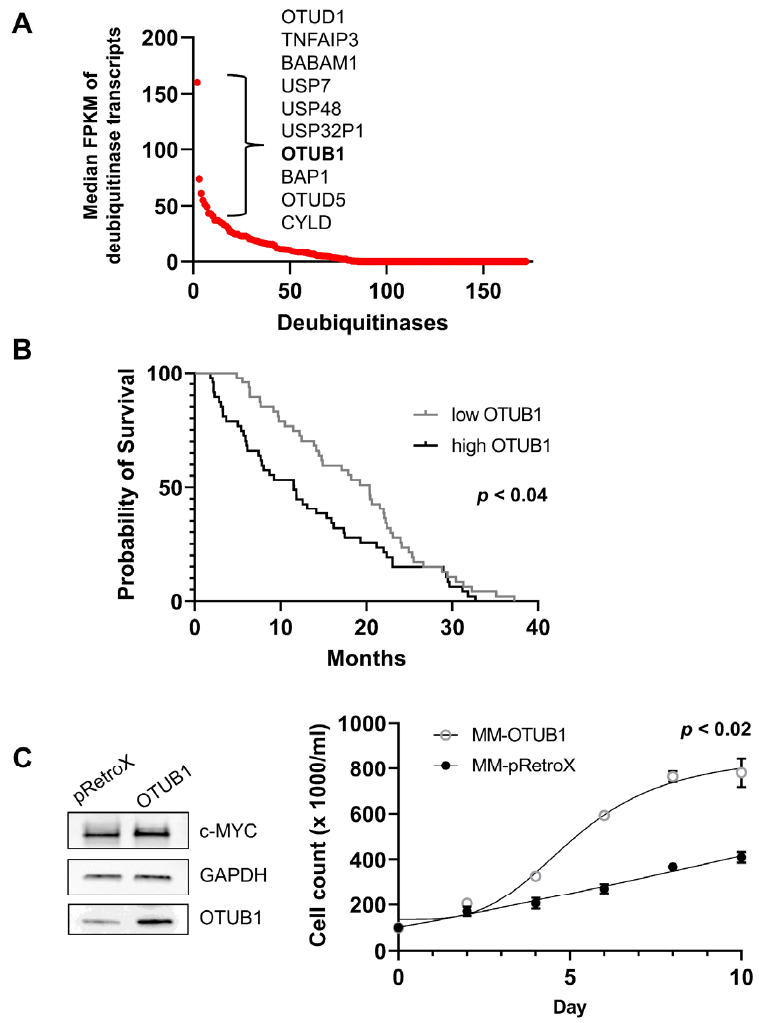
Figure 7. OTUB1 has oncogenic potential in multiple myeloma. ( A ) Analysis of expression levels of deubiquitinases in primary multiple myeloma cells of 811 patients. OTUB1 was among the top 10 enzymes of this class expressed in these cancer cells. ( B ) Multiple myeloma patients with elevated OTUB1 levels (top versus bottom quartile) showed worse clinical outcomes based on clinical data from the APEX study [41]. Mantel–Cox analysis of the Kaplan–Meier plot indicated that OTUB1 increases the oncogenic potential of the c-MYC-dependent cancer multiple myeloma ( p < 0.04). ( C ) Left panel: Immunoblot of MM.1S cells transduced with empty pRetroX control vector (left lane) or the OTUB1-encoding vector (right lane). Endogenous c-MYC was 1.5-fold increased based on densitometry in OTUB1-overexpressing cells (using GAPDH as a reference, not shown). Right panel: OTUB1-transduced MM.1S cells significantly outgrew cells transduced with the empty vector ( p < 0.02 by paired two-sided Student’s t -test after day 4). Uncropped immunoblots are provided as addendum in Figure S8.